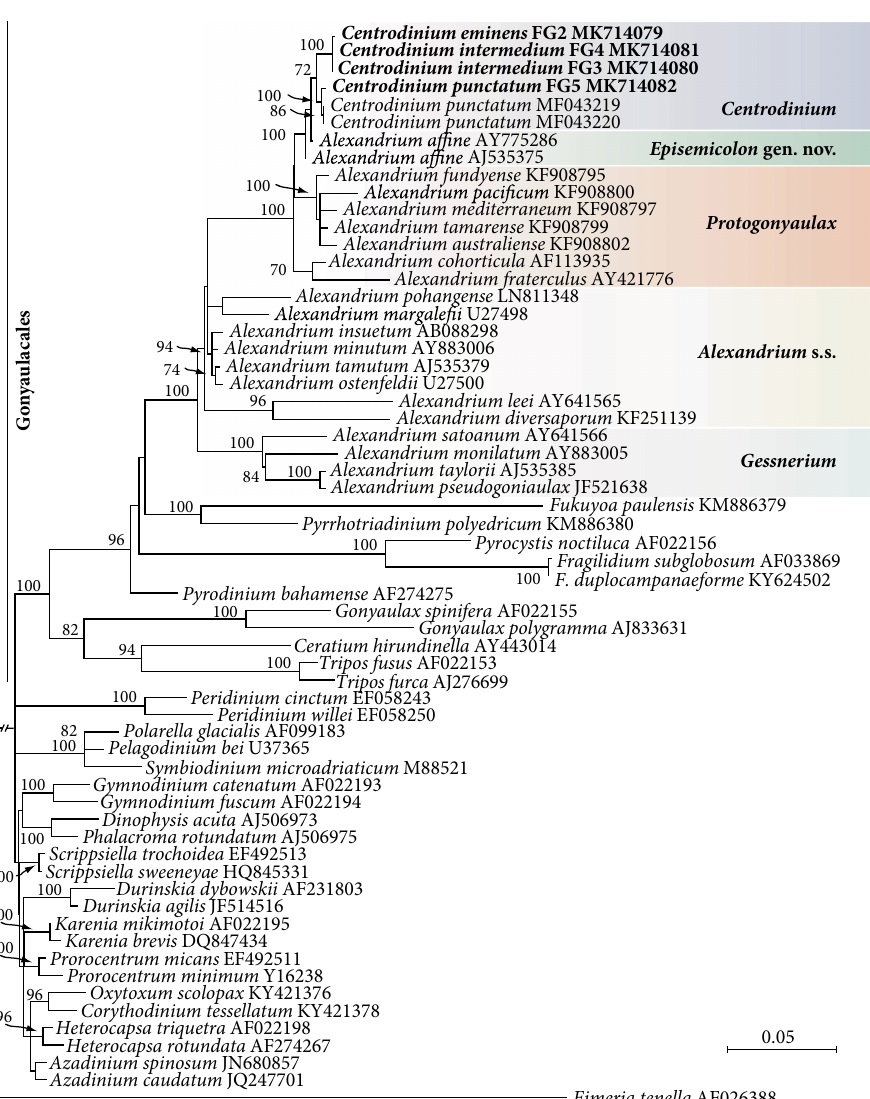
Figure 4: Maximum-likelihood phylogenetic tree of the SSU rRNA gene. Bootstrap support values (BP) >70 are shown. New sequences are highlighted in bold. The scale bar represents the number of substitutions for a unit branch